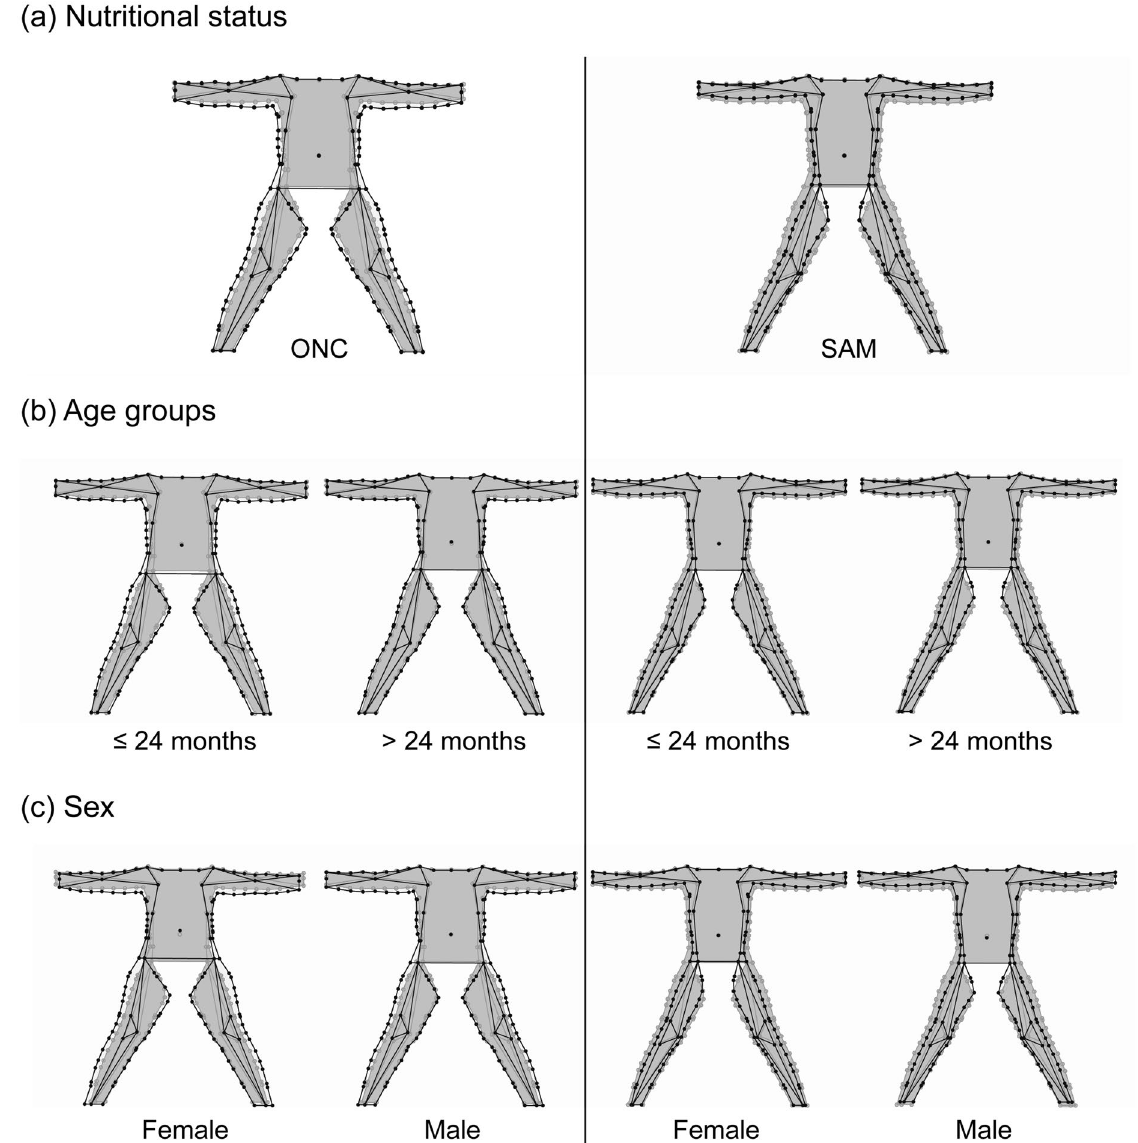
Figure 2. Mean shape variations of body shape in anterior view of infants and children aged 6–59 months before correcting for allometry. Consensus shape (grey) superimposed on the mean shape (black) for each level of the factors: nutritional status ( a ), age groups ( b ) and sex ( c